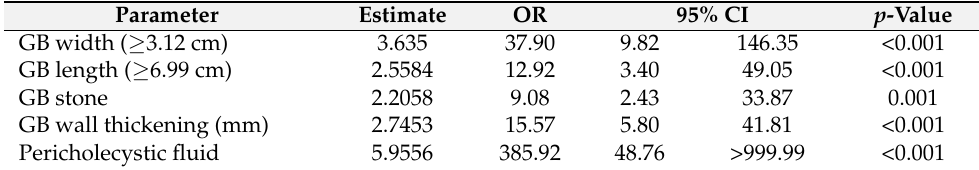
Table 4. Multivariable analysis for CT findings affecting acute